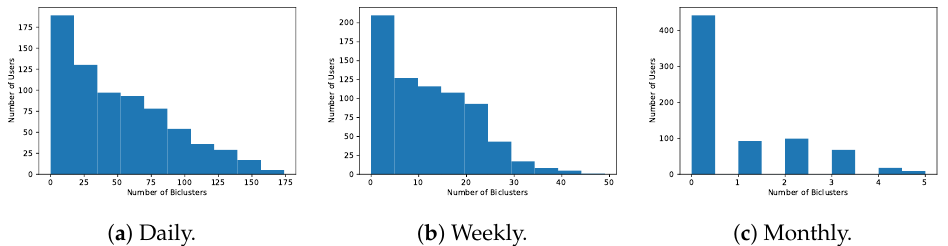
Figure 22. Number of patterns found for each user assuming constant patterns at InfraQuinta, 2017. Noise robustness Users with concordant consumption profiles might fail to be included in the same bicluster due to noise, e.g., sporadic deviations to regular water consumption. Noise may be further associated with discretization needs, introduced by a poor choice of discretization thresholds or an inadequate number of discretization symbols. Given this, we study